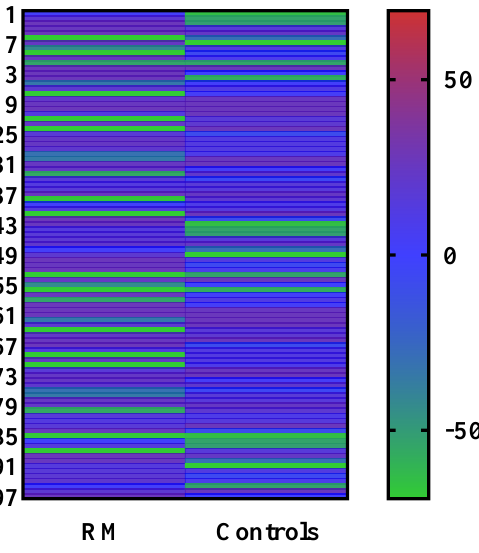
Figure 5. Heat map plot of IL17A samples (case vs. control).